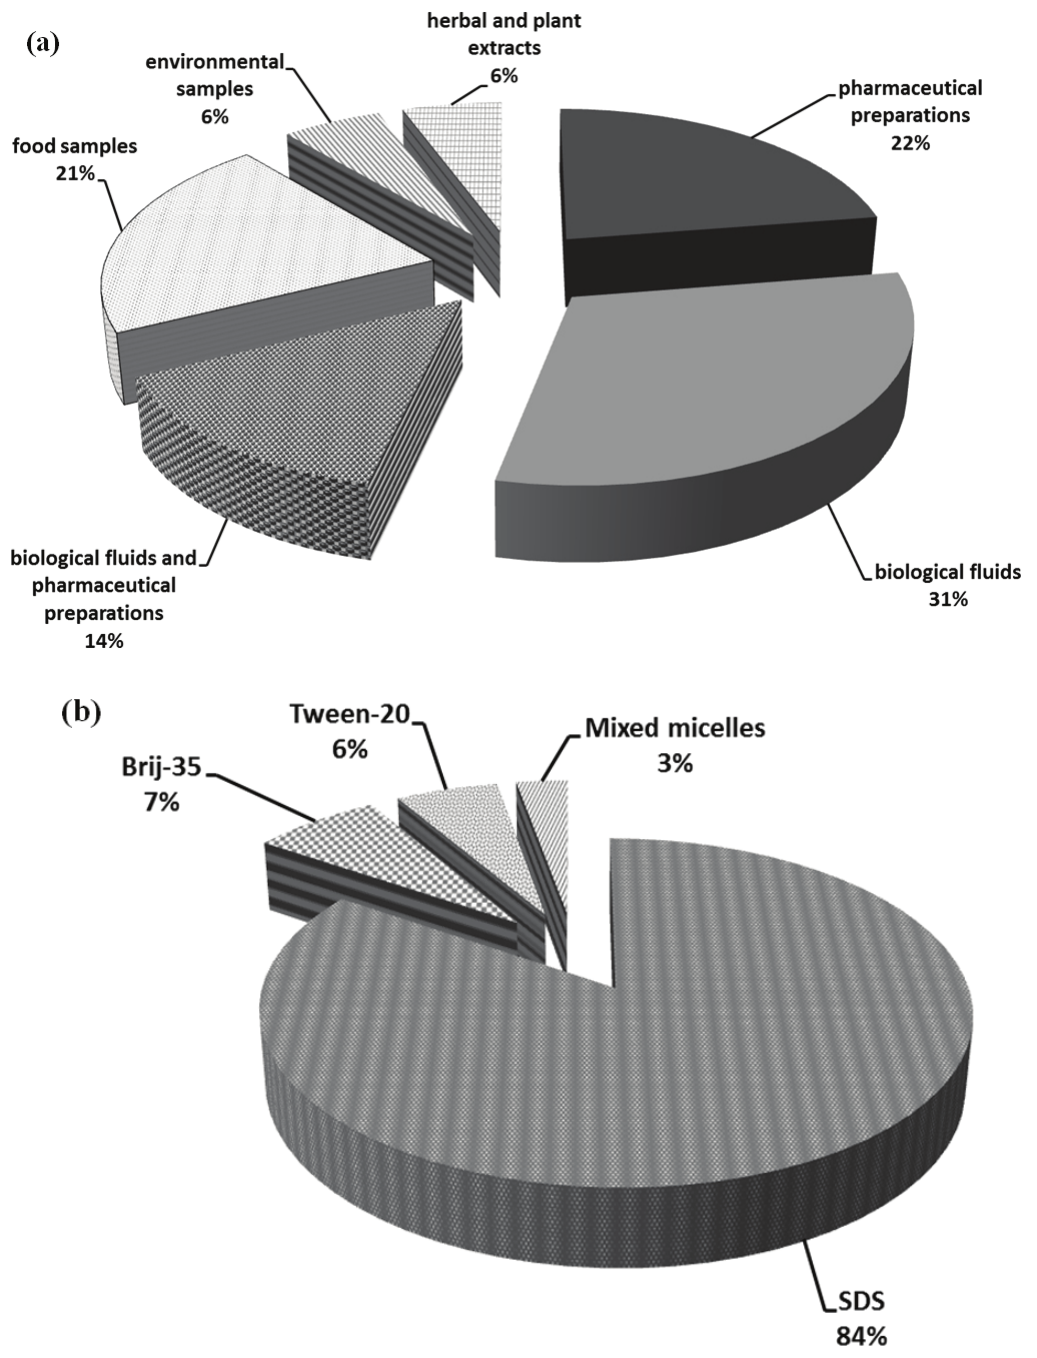
Figure 1: Frequency of (a) MLC applications in different fields and (b) using of different surfactants in MLC procedures, in the time period of 2010-early